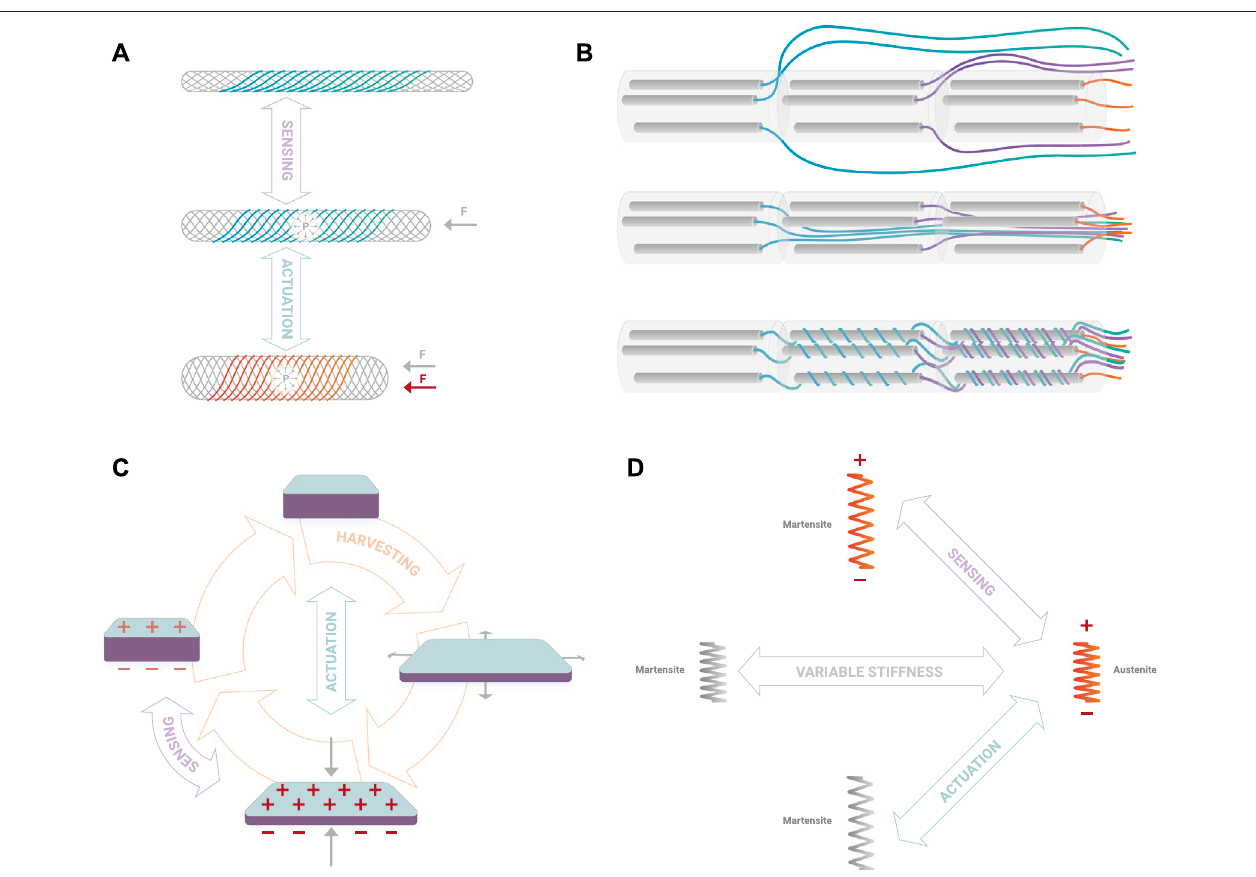
FIGURE1| Exampleoftechnologysynergisticmultifunctionality (A) whereaMcKibbenactuatorreliesonanexternalbraidednetpartiallymadeofSMAwiresableto sense deformations (inactive wires in blue) or to increase the generated force (active wires in red); example of static multifunctionality (B) where fl uid drive lines are arranged: externally leading to bulkiness (top), internally-straight increasing system stiffness (centre), or internally-helicoidal improving integration without impairing deformability (bottom); examples of dynamic multifunctionality depending on their driving conditions, where a Dielectric Actuator can serve as sensor, actuator or energy harvester (C) and a SMA can be used as sensor, variable stiffness mechanism or active actuator (D) .